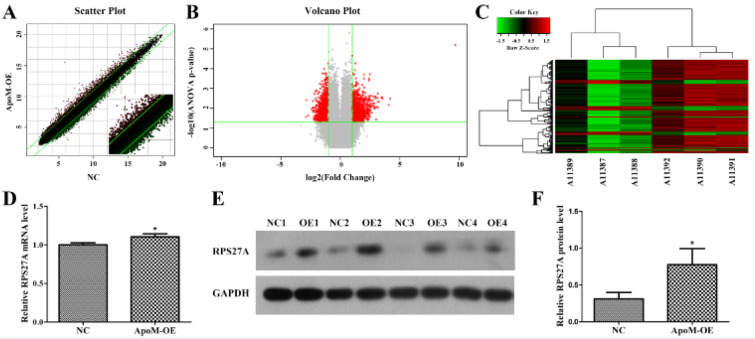
Differentially expressed genes between the ApoM-OE and NC groups. (A) Scatter plot. The X-axis represents the NC group, and the Y-axis represents the ApoM-OE group. (B) Volcano plot. The X-axis represents the logarithm conversion of the fold difference to base 2, and the Y-axis represents the logarithm conversion of the corrected significant levels to base 10. Red indicates all the probes with |Fold Change| > 2 and P < 0.05. (C) Heat map of hierarchical clustering. Each column represents a sample, and each row represents a differentially expressed gene. The upper dendritic structure indicates the aggregation or classification of all samples; the left dendritic structure indicates the aggregation of expression patterns of differentially expressed genes. (D) The relative RPS27A mRNA level in Caco-2 cells was determined by qPCR. (E) The RPS27A protein level in Caco-2 cells was determined by Western blotting. Both the ApoM-OE and NC groups include four replicates. GAPDH was the loading control. (F) The relative RPS27A protein level was significantly higher in the ApoM-OE group than in the NC group. The data are presented as the means ± SD. Student's t test was used to analyze significant differences; *P < 0.05 versus NC. ApoM, apolipoprotein M; qPCR, quantitative PCR; RPS27A, ribosomal protein S27a; OE, overexpression; NC, negative control.